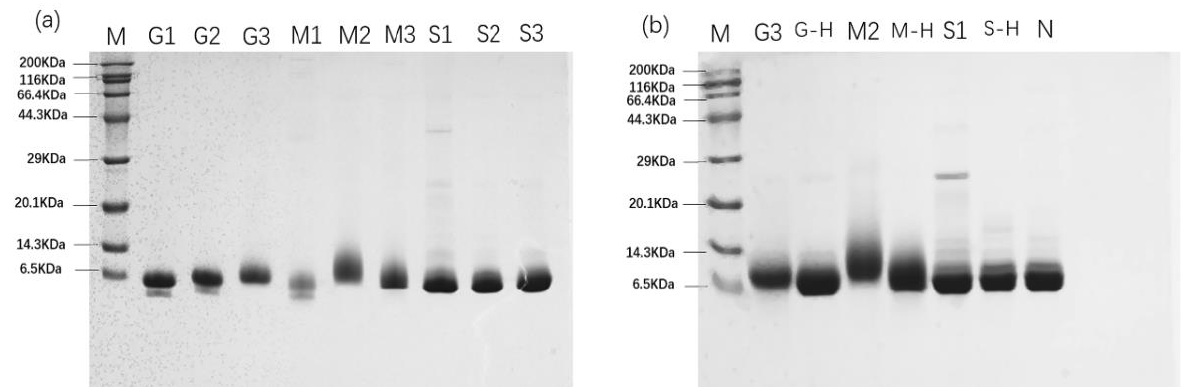
of parvalbumin, named PV-I (99% coverage) and PV-II (75% coverage), respectively (data shown as Figure 2).